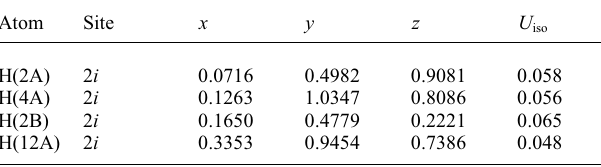
Table 2. Atomic coordinates and displacement parameters (in Å 2 )